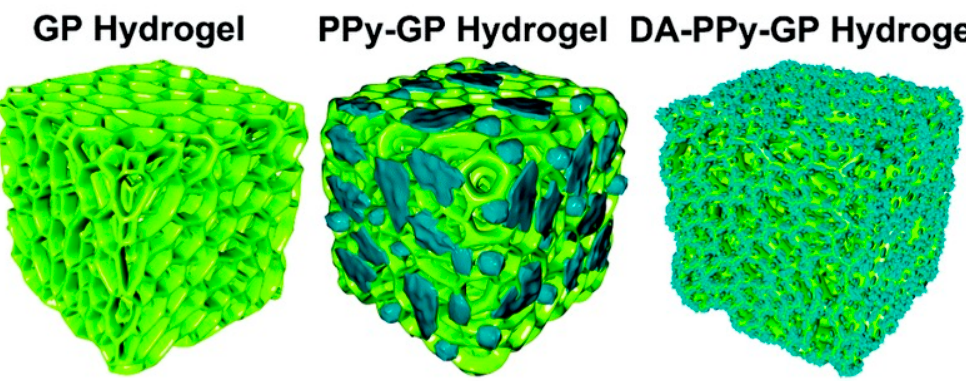
Figure 2. A schematic of structure and morphology for an elastomeric gelatin methacrylate- polyacrylamide (GP) double network hydrogel, polypyrrole (PPy) incorporated GP hydrogel, and dopamine (DA)-PPy-GP hydrogel. Reproduced with permission from [59]. Copyright 2019, Royal Society of Chemistry.